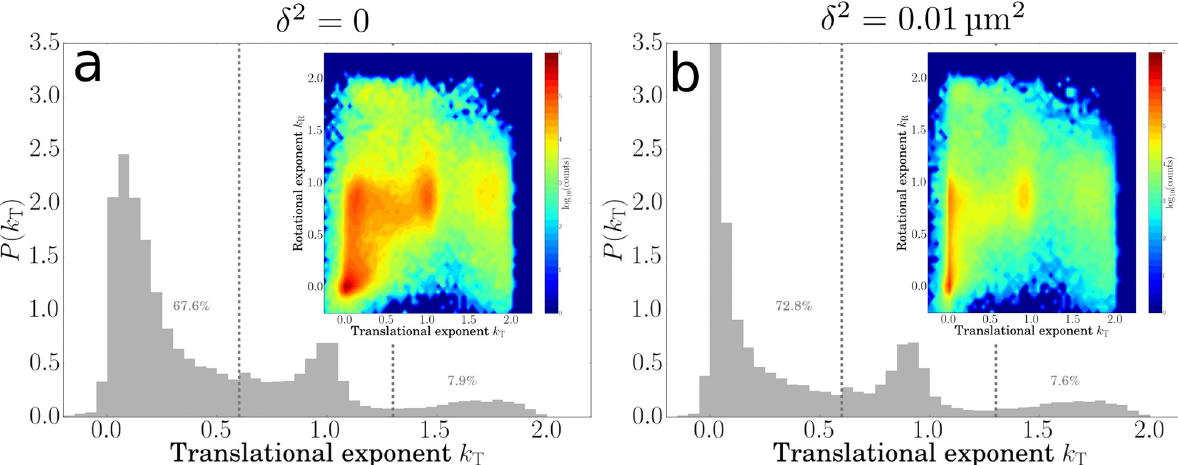
Fig 8. How systematic errors affect the exponent landscape. Histograms of translational exponents k 0 : 4 s ( δ 2 = 0), and (b) with a systematic error δ 2 = 0.01 μ m 2 added to the MSD. Insets show 2D corresponding histograms for translational and rotational exponents. Note the shift in the position of the peaks for k T , while the position in k R remains